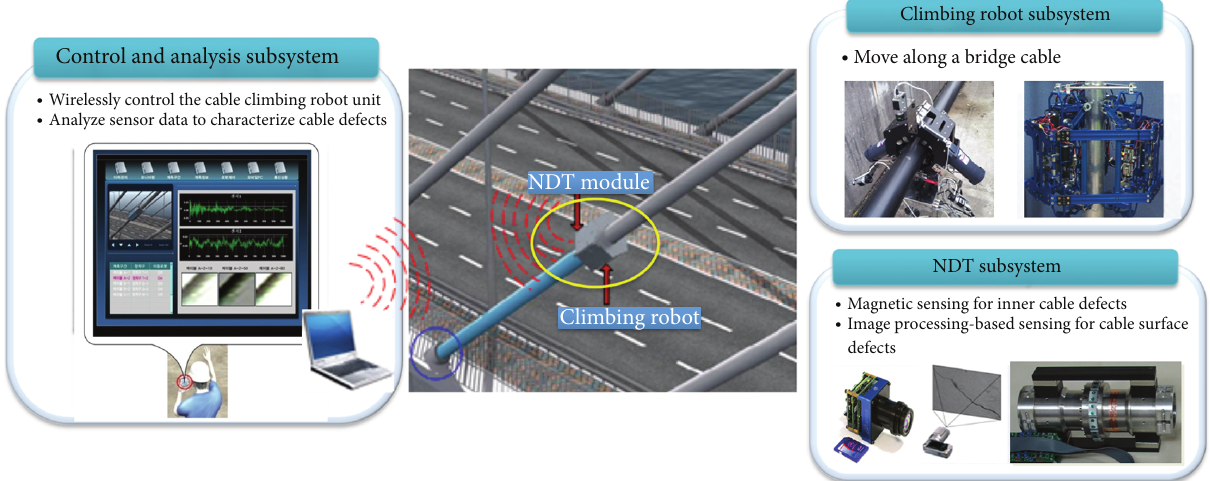
Figure 14: System components of cable inspection robot developed in Korea.